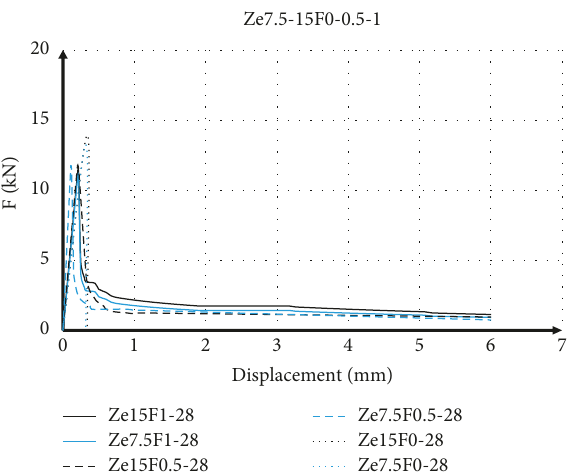
Figure 11: Effect of MPW fiber on flexural behavior of concrete containing zeolite at 28 days.